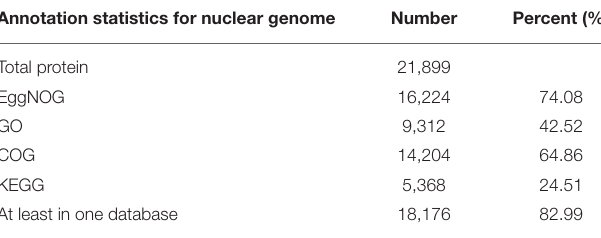
TABLE 3 | General function annotation results statistics. Annotation statistics for nuclear